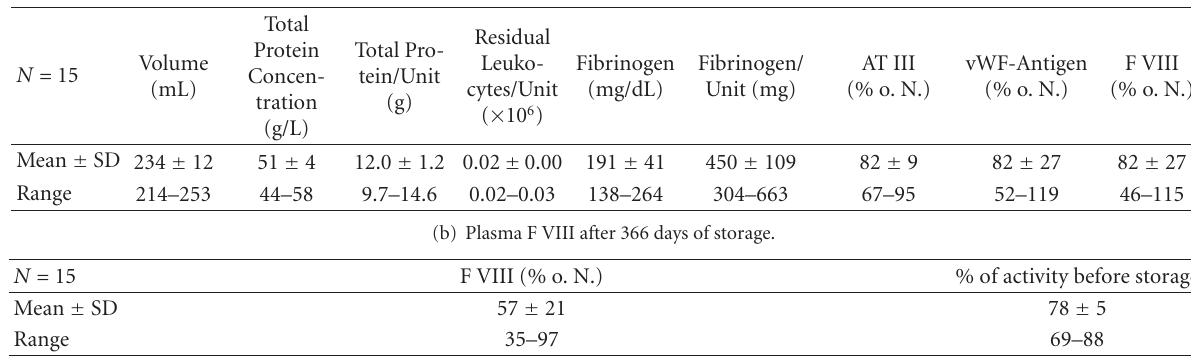
(a) Plasma directly after preparation.